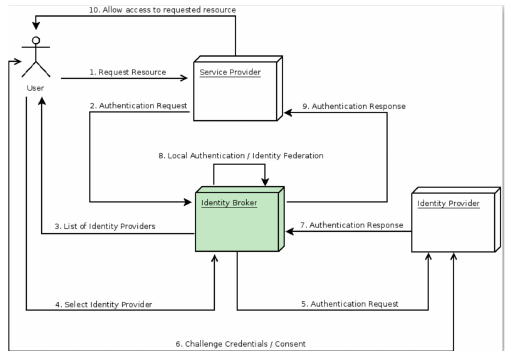
Figure 3. Interaction between an identity broker, service provider, identity provider and user when using identity brokering